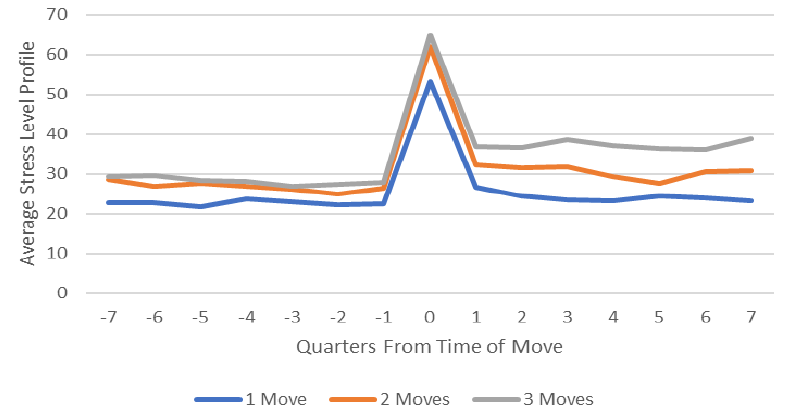
Figure 3. Average stress of both owners and renters, by frequency of moves within 5 years. Notes: (1 Move ( n = 3609), 2 Move ( n = 3753), 3 move ( n = 1773)).